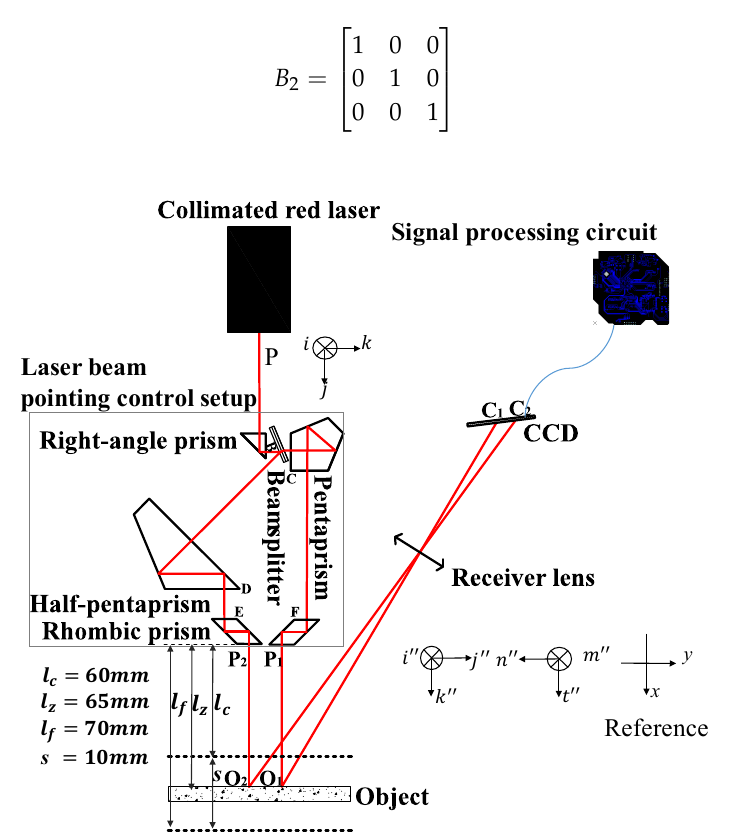
Figure 3. Optical structure of the scheme for reduction of the influence of laser beam directional dithering in laser triangulation displacement